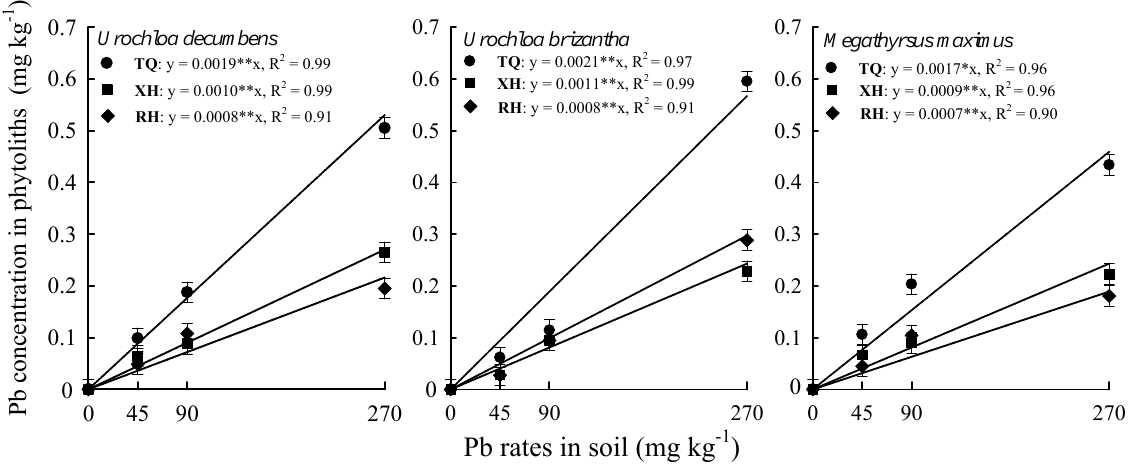
Figure 4. Pb concentrations in phytoliths of forage grasses with increases in Pb rates within 120 days of thinning in three soils (TQ: Typic Quartzipsamment. XH: Xantic Hapludox. RH: Rhodic Hapludox) (significant at ** p = 0.01).